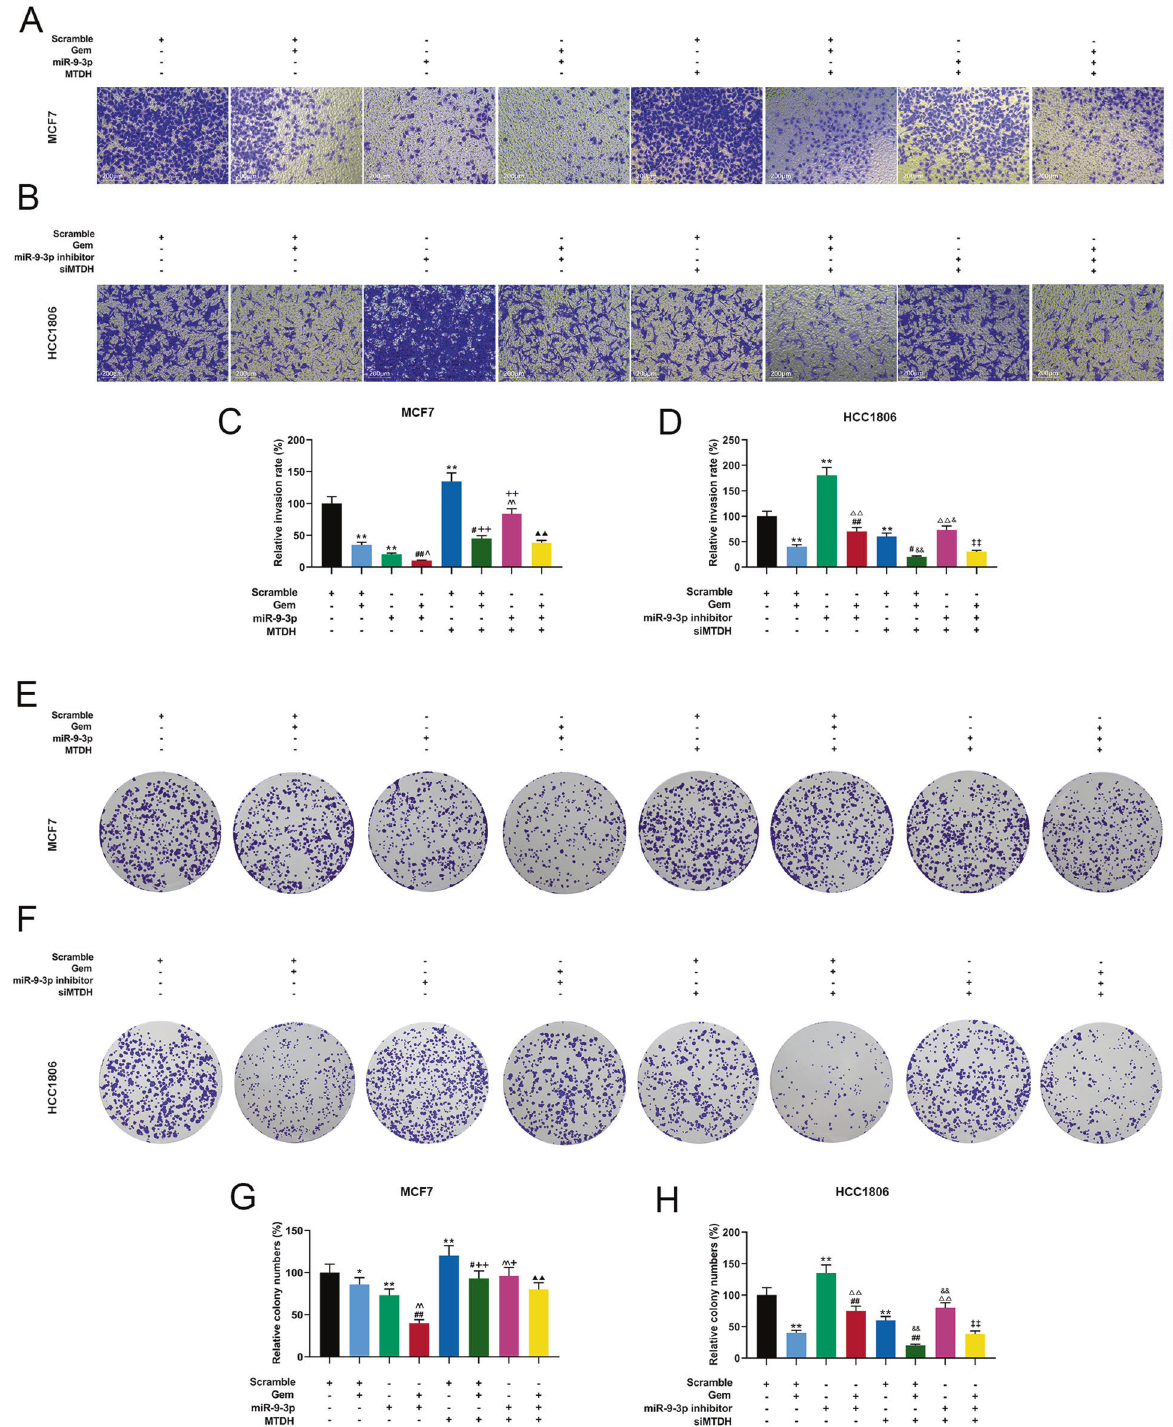
Fig. 7 The effects of miR-9-3p on invasion and growth of Gem-treated breast cancer cells by targeting MTDH. A , C Transwell was used to determine the effects of overexpressed MTDH, miR-9-3p mimics, and Gem on the invasion of MCF7 cells. B , D Transwell was used to determine the effects of siMTDH, miR-9-3p inhibitor, and Gem on the invasion of HCC1806 cells. E , G Cell cloning experiment was used to detect the effects of overexpressed MTDH, miR-9-3p mimics and Gem on clone ability of MCF7 cells. F , H Cell cloning experiment was used to detect the effects of siMTDH, miR-9-3p inhibitor, and Gem on clone ability of HCC1806 cells. ( n = 3, * P < 0.05, ** P < 0.01, *** P < 0.001, vs. Scramble; ## P < 0.01, vs. Scramble + Gem; ^^ P < 0.01, vs. miR-9 mimics) ( n = 3, + P < 0.05, ++ P < 0.01, vs. Scramble + MTDH; ▲ P < 0.05, ▲▲ P < 0 . 01, vs. miR- 9 mimics + Gem; △△ P < 0.01, vs. miR-9 inhibitor; && P < 0.01, vs. Scramble + siMTDH; ‡‡ P < 0.01, vs. miR-9 inhibitor + Gem). MTDH Metadherin.